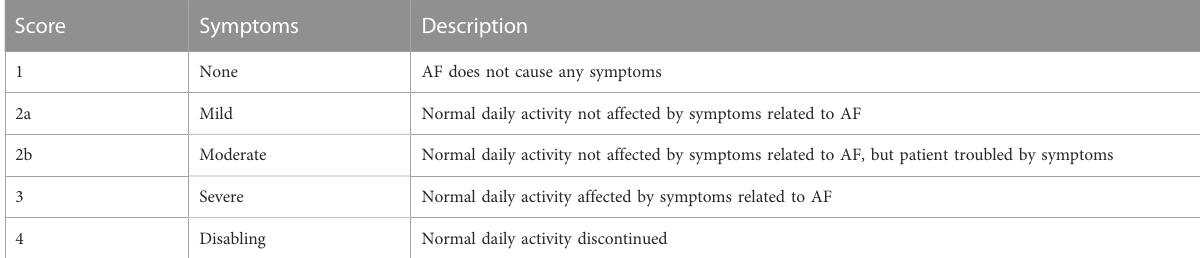
TABLE 4 EHRA (European Heart Rhythm Association) symptom scale (Hindricks et al., 2021).